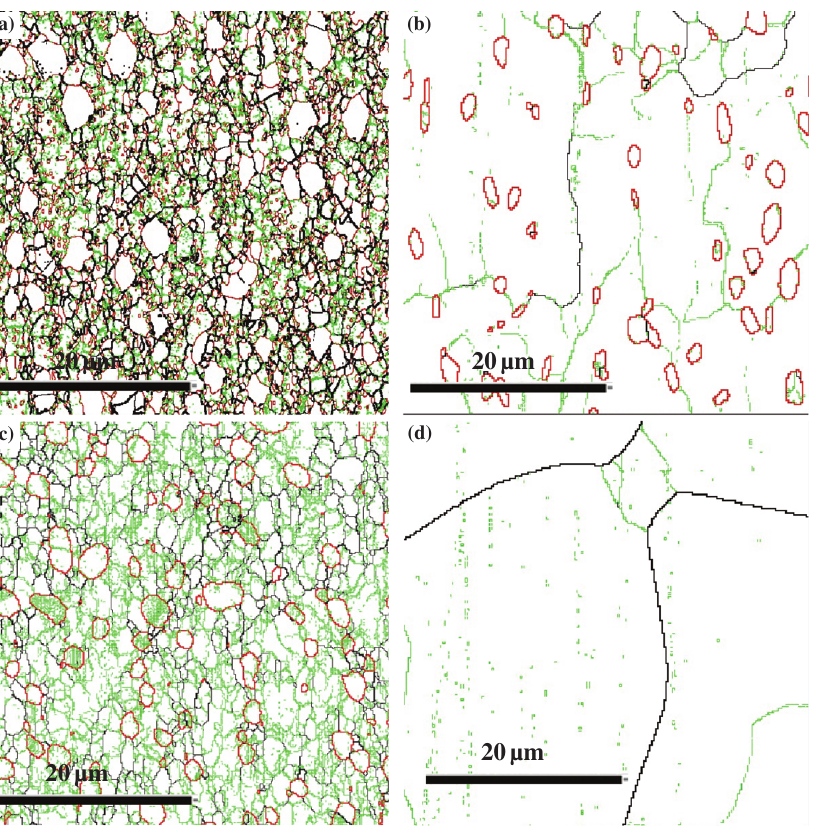
Figure 16: The grain boundary orientation map of Ti555211 alloy after hot deformation: (a) 750°C, 0.001 s − 1 ; (b) 800°C, 1 s − 1 ; (c) 800°C,